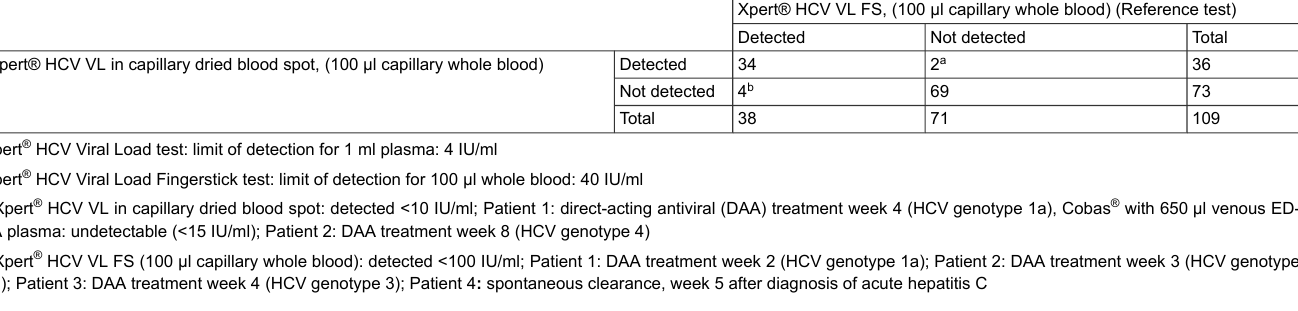
Table 2: Qualitative performance / diagnostic accuracy of the Xpert ® HCV Viral Load (VL) test in capillary dried blood spots (100 µl capillary whole